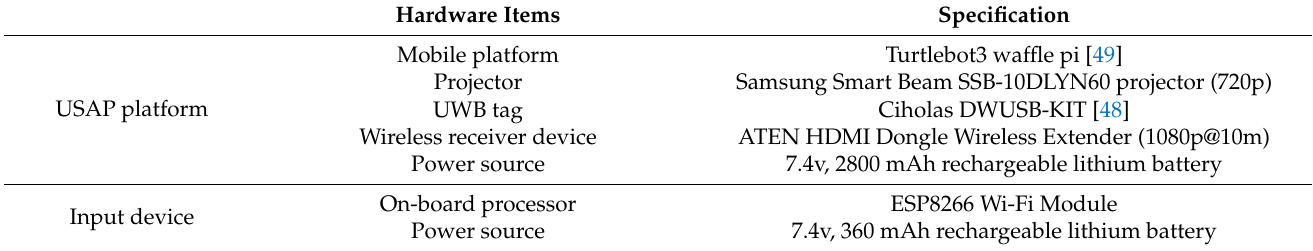
Table 1. Hardware specifications of the UWB-driven self-actuated projector (USAP) platform and input device.